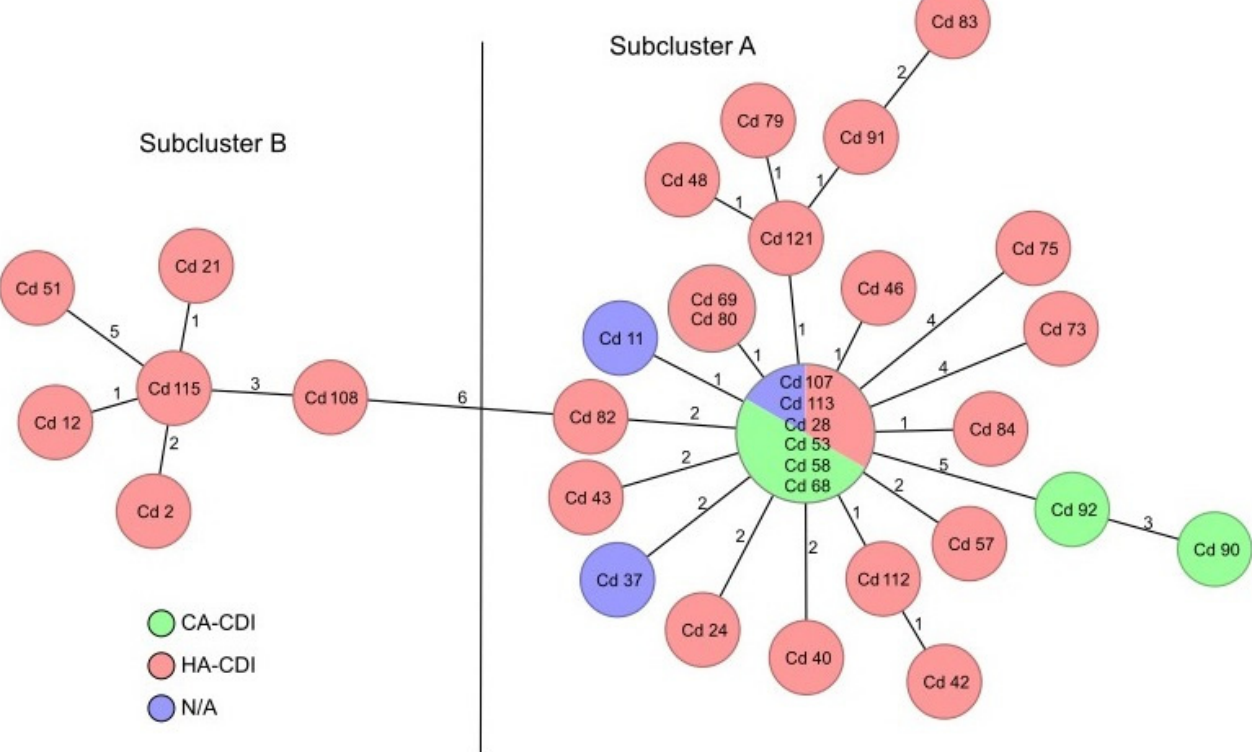
Figure 2. Minimum-spanning tree based on cgMLST analysis demonstrating the clonal relationship of all RT027 isolates investigated. Each circle represents the genotype based on a unique allelic profile of up to 2147 cgMLST genes (ignoring missing values in pairwise comparisons), and the numbers on connecting lines show the number of differing alleles. The circles are named by the isolate labels and sizes are related to the number of isolates with the same allelic profile. The colour of the circle provides additional epidemiological information (CA-CDI, HA-CDI, and N/A—not applicable due to the fact that the isolates Cd 11, Cd 28, and Cd 37 originated from another hospital). The black line divides the genotypes in subclusters A and B.